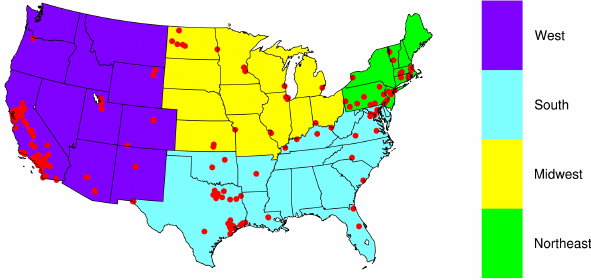
Figure 1. Region definitions and locations of NO 2 surface observa- tion sites used in this